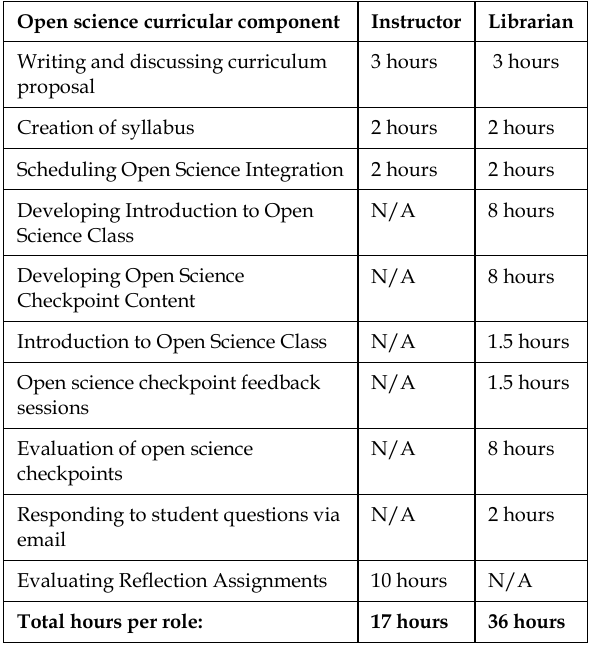
Table 1 Time commitment required for OS curriculum